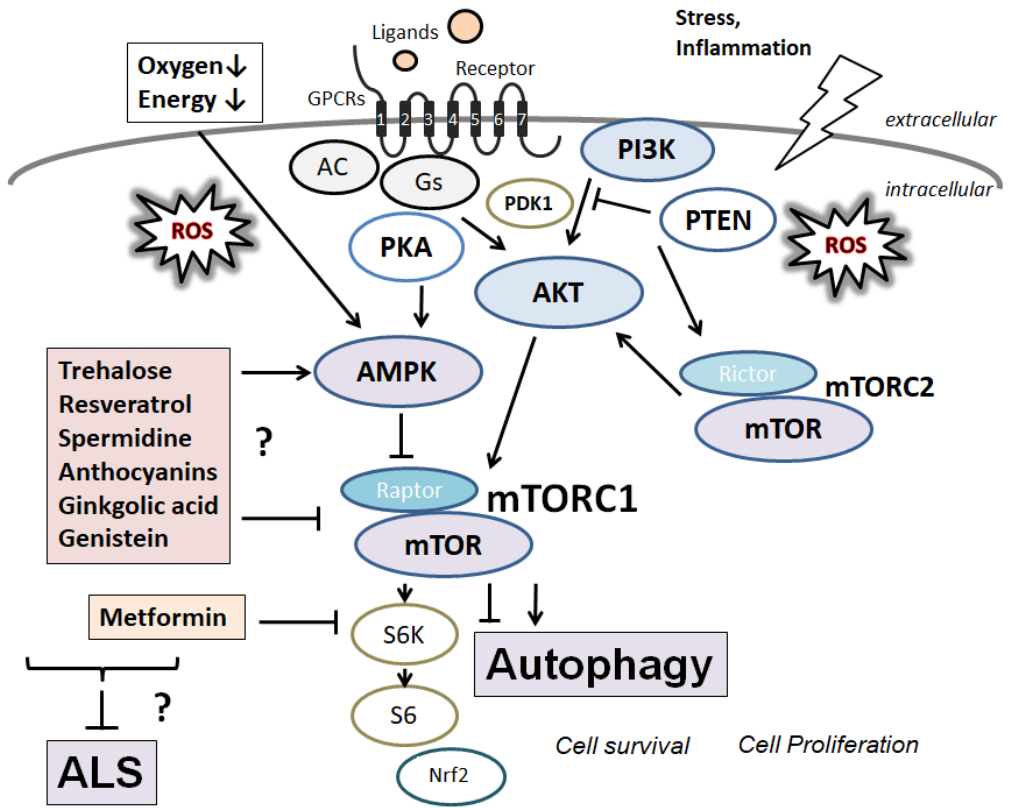
Figure 2. Selected signaling pathways involved in the induction of autophagy with indication of the sites of action of several natural compounds affecting them. Several modulator molecules linked to the PI3 K/AKT/mTOR/mTORC1 signaling pathway are demonstrated. Example compounds from natural sources known to act on the AMPK/mTOR and/or autophagy signaling are also shown. An arrowhead means stimulation, whereas a hammerhead represents inhibition. Note that some critical events, such as immune activation and/or antioxidant feedback, have been omitted for clarity. Abbreviations: AMPK, adenosine monophosphate-activated protein kinase; mTOR, mammalian/mechanistic target of rapamycin; PI3 K, phosphoinositide-3 kinase; PKA, protein kinase A; PTEN, phosphatase and tensin homolog deleted on chromosome 10; mTORC, mechanistic/mammalian target of rapamycin complex; ALS, Amyotrophic Lateral Sclerosis.